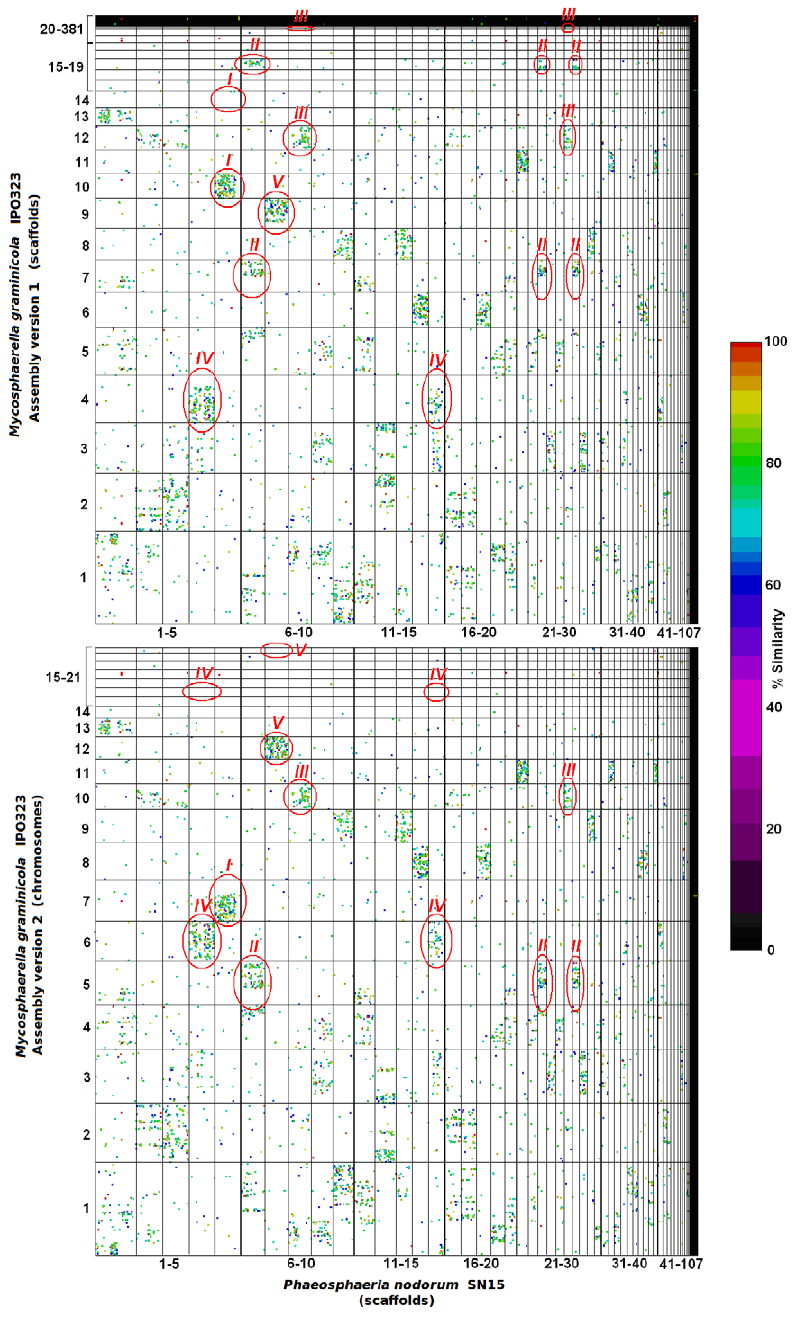
Figure 5. Comparisons of Mycosphaerellagraminicola genome assembly versions 1 and 2 against that of Stagonosporanodorum isolate SN15. Scaffolds/chromosomes are ordered along their respective axes according to both decreasing length and increasing number. The 6- frame translations of both genomes were compared via MUMMER 3.0 [53]. Homologous regions are plotted as dots, which are color coded for percent similarity as per the bar on the right. Amendments made in the version 2 assembly and their corresponding regions in assembly version 1 are circled in red. Version 2 chromosomes 5 (B, circle II), 7 (B, circle I) and 10 (B, circle III) were derived from joined version 1 scaffolds 7 and 17 (A, circle II), 10 and 14 (A, circle I) and 12 and 22 (A, circle III), respectively, validating the method. Observation of the mesosyntenic pattern also could be used to identify inappropriately joined scaffolds. For example, M. graminicola v2 chromosomes 6 and 16 (B, circle IV) and 12 and 21 (B, circle V) were derived from split version 1 scaffolds 4 (A, circle IV) and 9 (A, circle V), respectively. These scaffolds are characterized by an abrupt termination of the mesosyntenic block at the split point as indicated by red lines (A, circles IV and V). A total of 21 predictions was made and 14 were validated. doi:10.1371/journal.pgen.1002070.g005 lifestyle [43]. Based on these results we propose a novel, biphasic facilitate pathogenicity and function as effectors in other fungi. mechanism of stealth pathogenesis. During penetration and early Instead of the usual carbohydrate metabolism, nutrition during the colonization, M. graminicola produces a reduced set of proteins that extended biotrophic phase may be by degradation of proteins